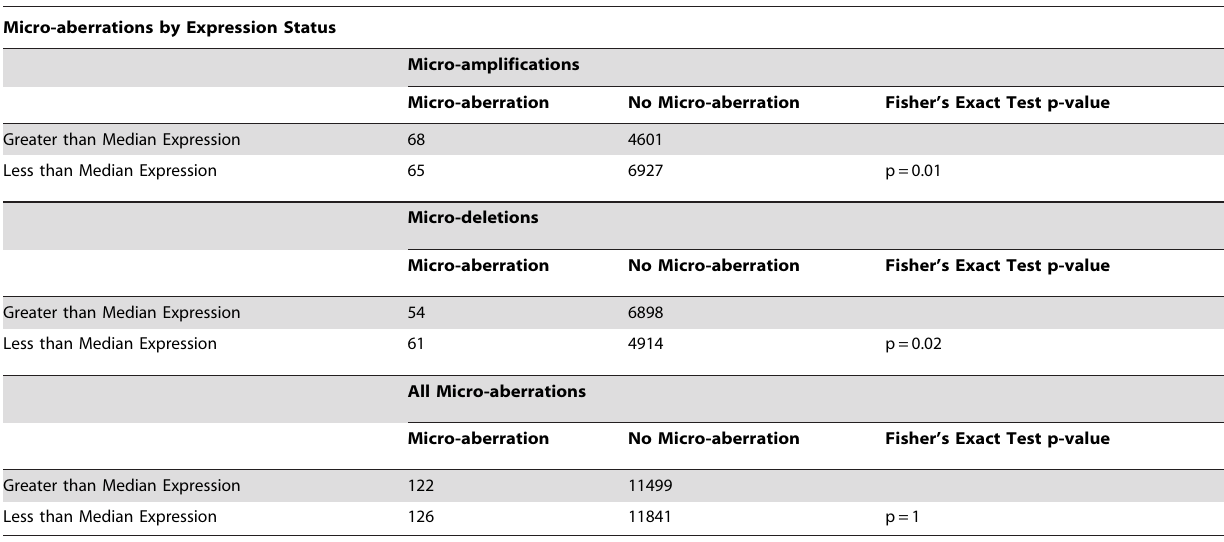
Table 3. Analysis of Gene Expression Relative to Median Expression by Aberration Type.